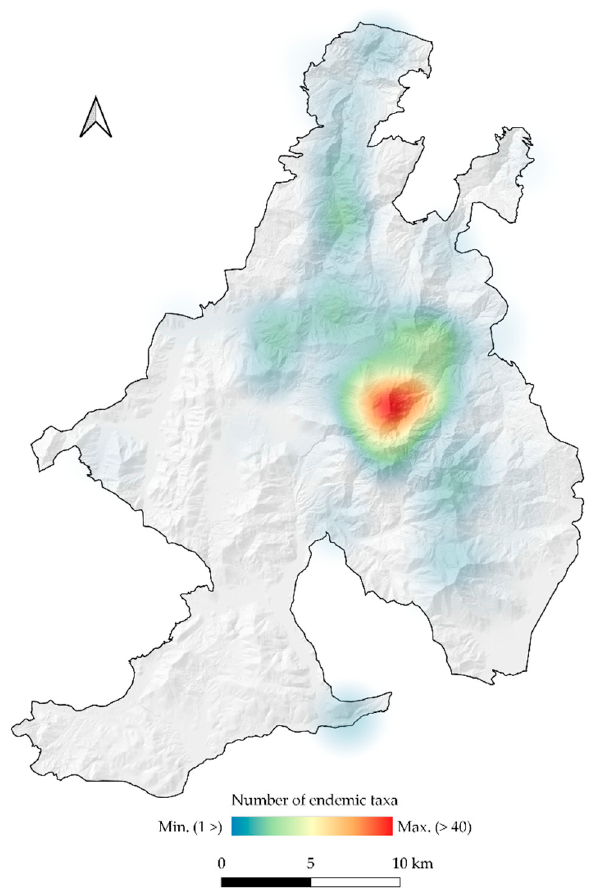
Figure 3. Endemic diversity hotspots in the CVNP area.